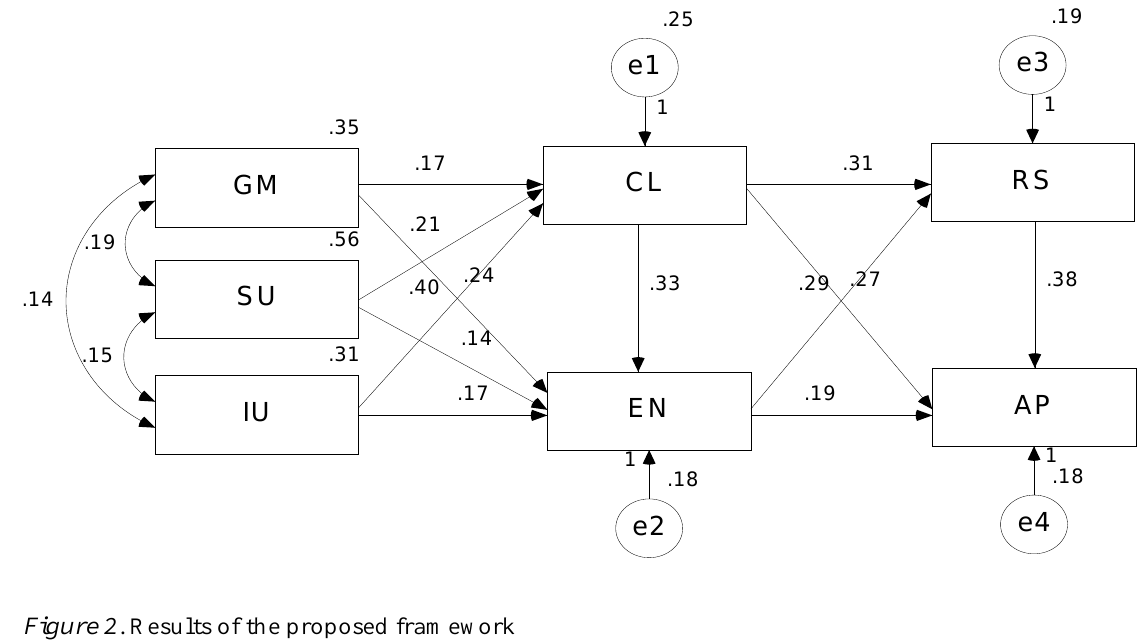
Figure 2 . Results of the proposed